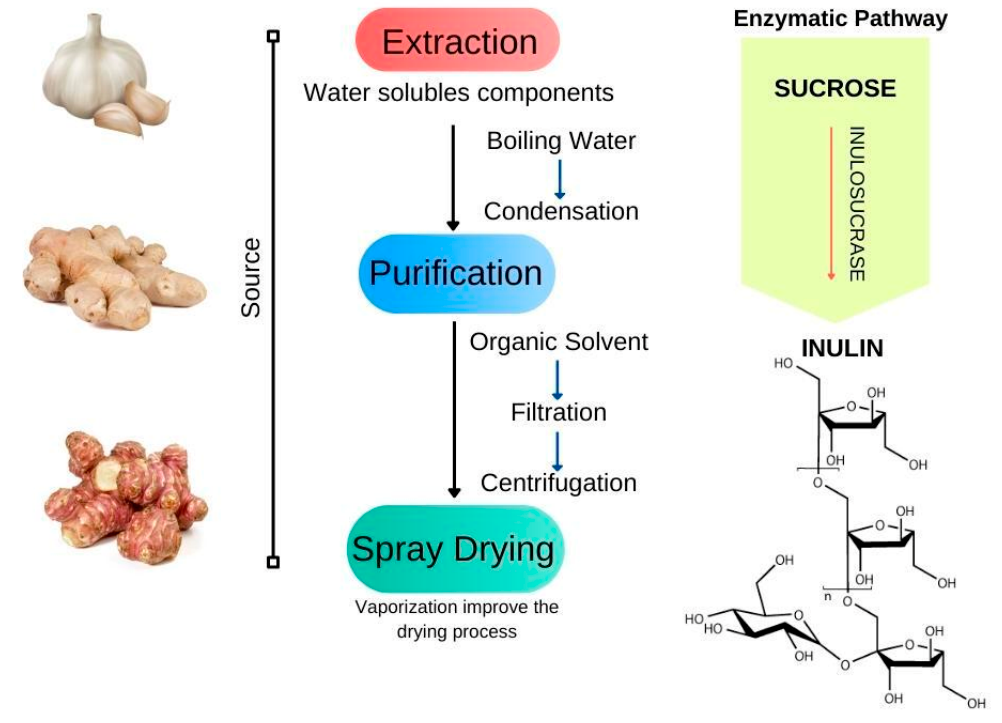
Figure 9. Inulin: sources and obtaining methods.